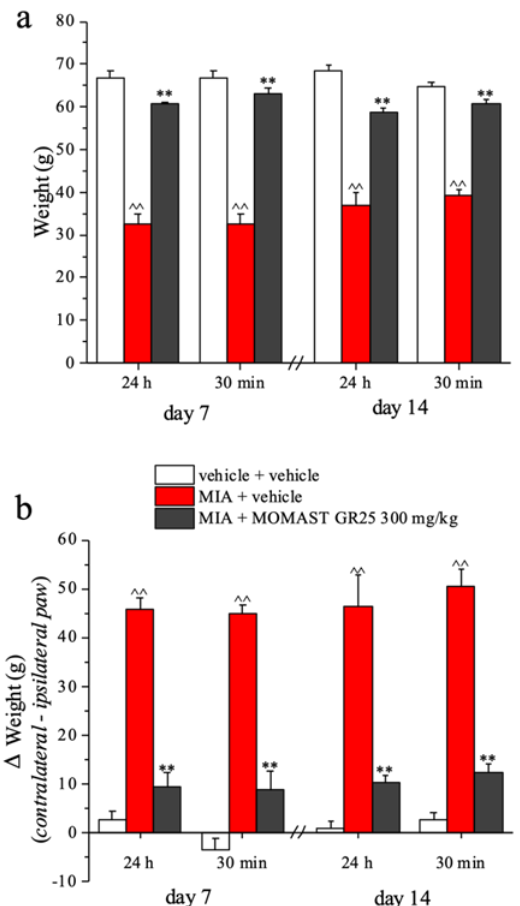
Figure 4. Effect of repeated administration of MOMAST ® GR25 on monoiodoacetate (MIA)-induced osteoarthritis, ( a ) paw pressure test; ( b ) incapacitance test. Osteoarthritis was induced by the injection of MIA (2 mg/25 µ L) into the tibio-tarsal joint. Starting from MIA injection (day 1), MOMAST ® GR25 300 mg/kg was suspended in 1% carboxymethylcellulose sodium salt (CMC) and orally administered twice daily. Behavioral measurements were performed 24 h and 30 min after administration on days 7 and 14. Each value represents the mean of six rats performed in two different experimental sets. One-way analysis of variance (ANOVA), p < 0.05; post-hoc test, ˆˆ p < 0.01 vs vehicle + vehicle treated animals; ** p < 0.01 vs MIA + vehicle treated animals.